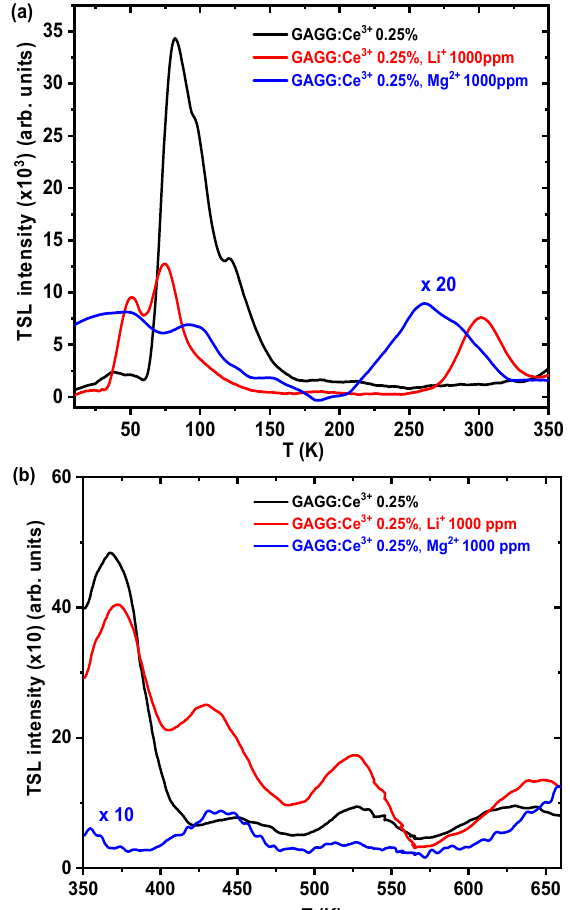
Figure 7. Thermoluminescence glow curves of as-grown GAGG:Ce, GAGG:Ce,Li, and GAGG:Ce,Mg single crystals after UV irradiation (12.40 eV) at ( a ) 10 K and recorded between 10 and 350 K; ( b ) irradiated at 300 K and measured between 350 and 670